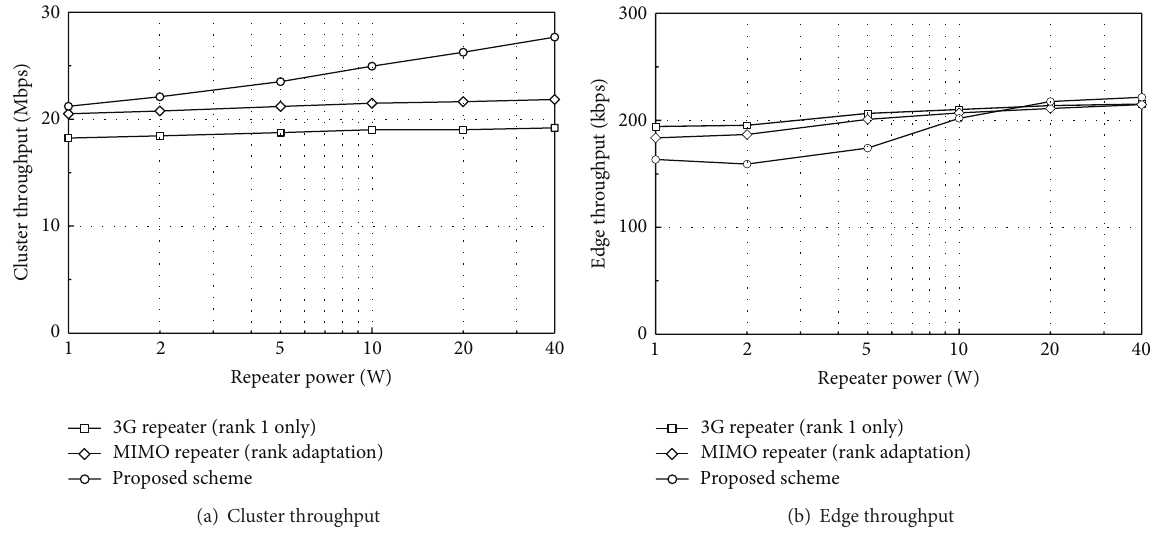
Figure 6: Performance comparison at different transmission power of